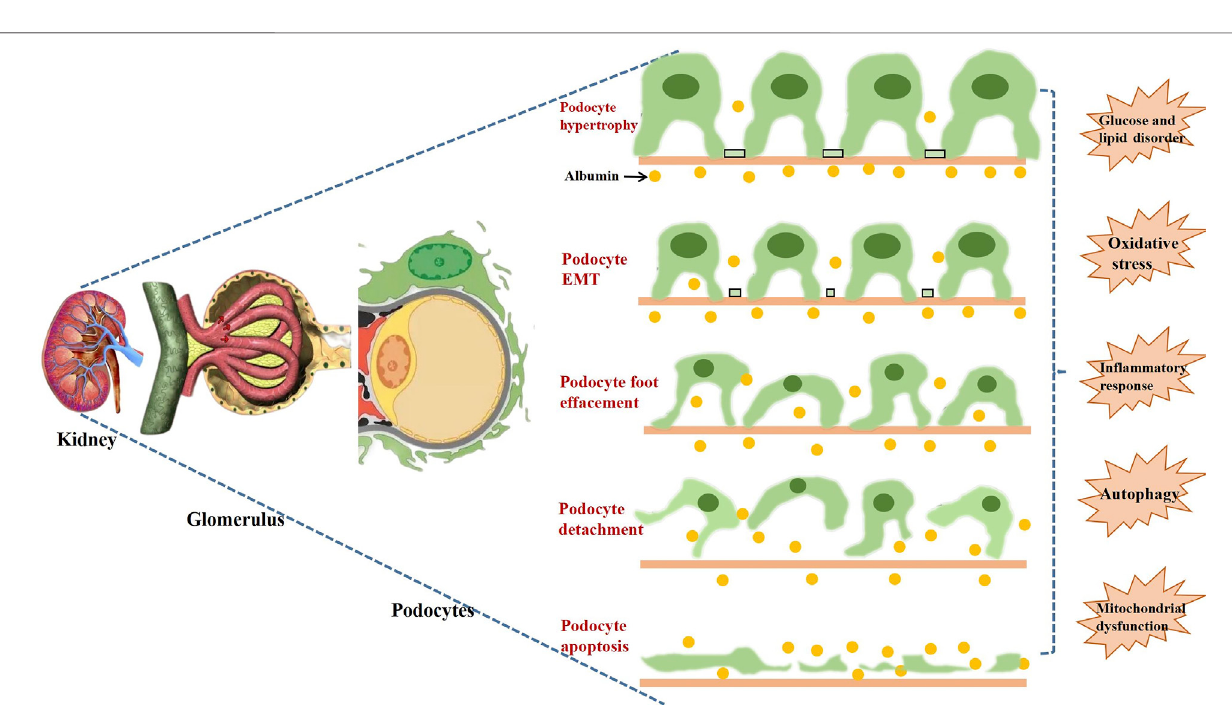
FIGURE 2 | Different pathological processes of podocyte injury and its common